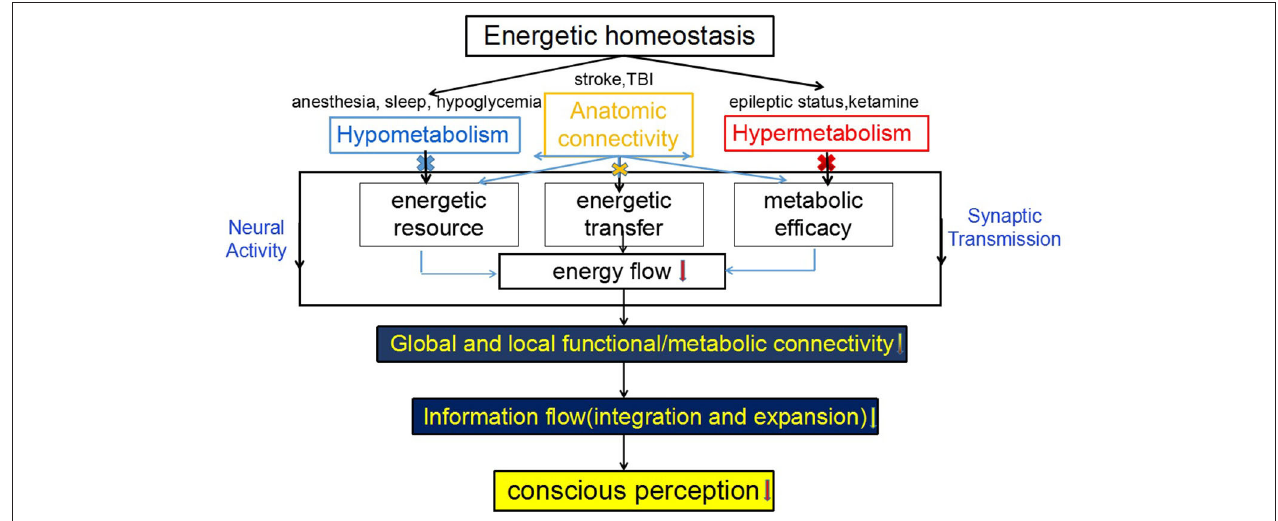
FIGURE 5 | Schematic diagram of a coupling between energetic homeostasis and consciousness. The normal neuroglia metabolism maintains energetic homeostasis in the brain. The hypometabolism, hypermetabolism, or anatomic disconnection results from the reduced supply of energy substrate(s), metabolic efficacy or energetic transfer or communication, as a result, lower energy flow cannot drive neural activity and synaptic transmission, leading to the disruption of local and/or global functional/metabolic connectivity (MC), and the failure of information integration and globalization, and thereby the loss of